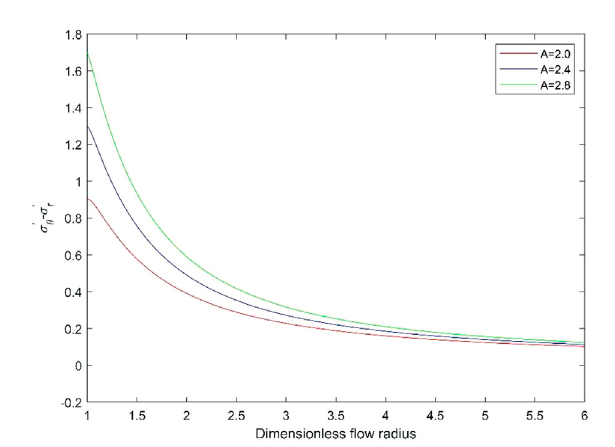
FIGURE 5 Difference between effective circumferential stress and effective radial stress in the acceleration fl ow for various A.